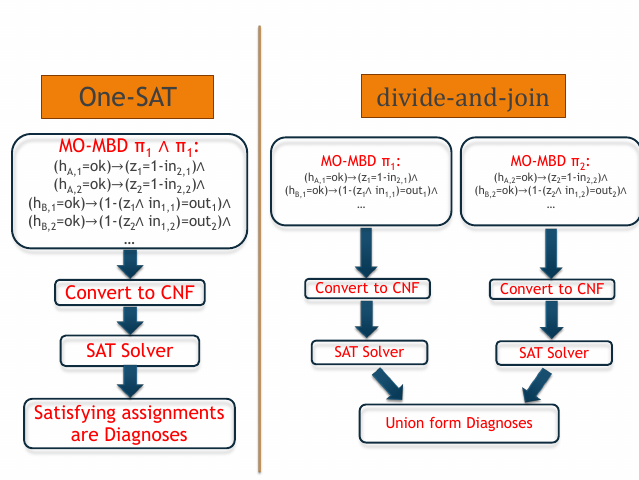
Figure 1. A diagram of the proposed two approaches.